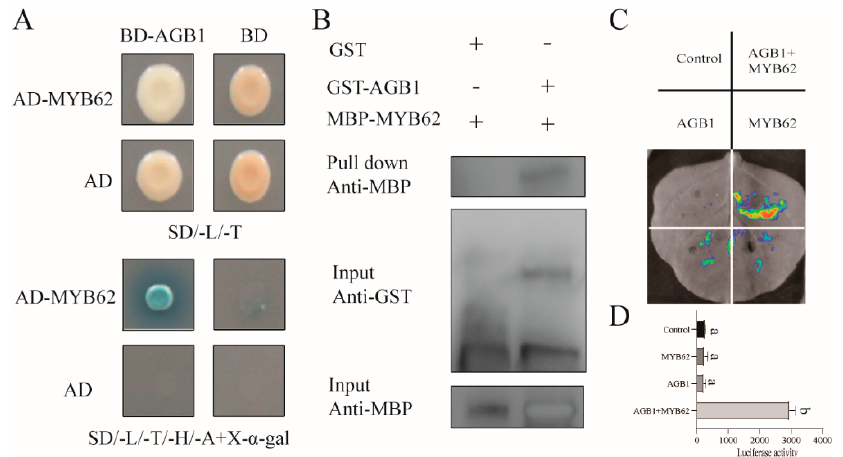
Figure 2. The interaction between AGB1 and MYB62 . ( A ) Yeast two-hybrid interactions between full-length sequences of AGB1 and MYB62 . The transformed yeast cells were activated and cultured on SD/-Leu/-Trp and SD/-Leu/-Trp/-His/-Ade media. The yeast cells of the empty vectors AD and BD were used as negative controls. ( B ) Protein interaction of AGB1 and MYB62. In vitro GST pull-down assays showed that AGB1 interacted with MYB62 in vitro. ( C ) Interaction of AGB1 with MYB62. A luciferase (LUC) assay was performed to demonstrate that AGB1 and MYB62 can interact with N. benthamiana leaf cells. AGB1 and MYB62 were fused with nLUC and cLUC, respectively. nLUC-only and cLUC-only refer to the empty vectors used as negative controls. ( D ) Quantification of luminous intensity in C. Error bars represent the means ± SE ( n = 3). Significant differences were analyzed using Duncan’s multiple range test ( p < 0.05).